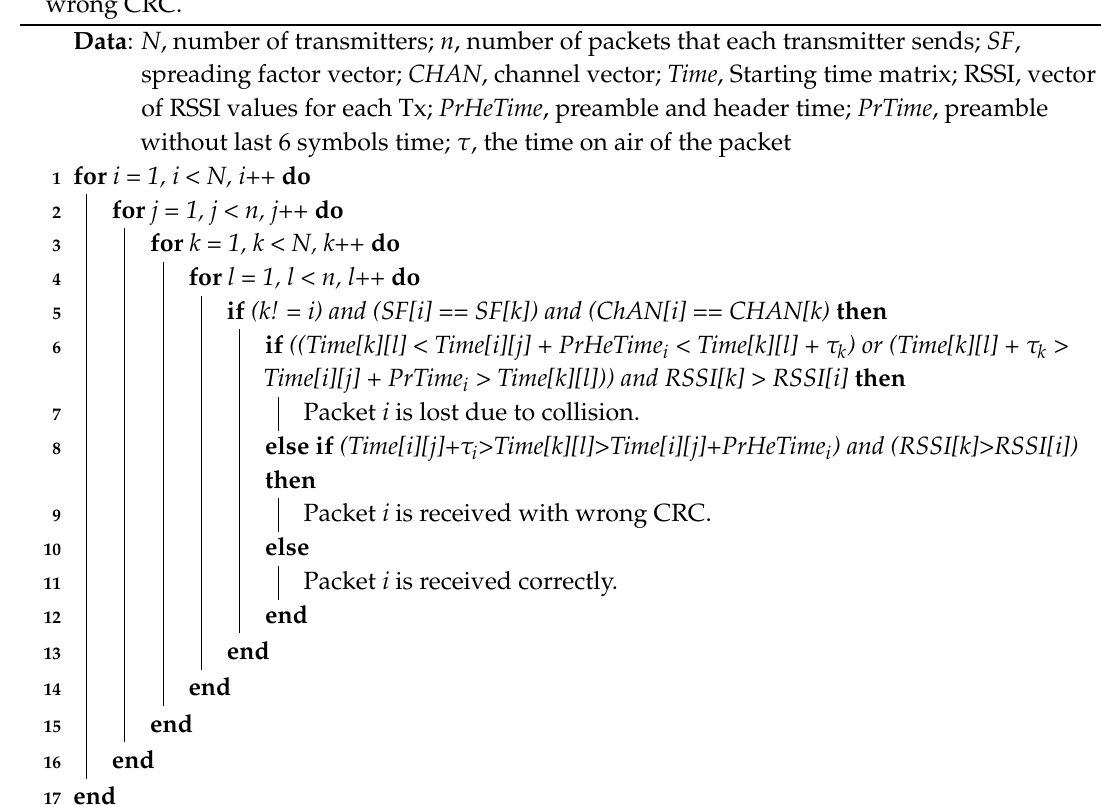
Algorithm 1: Algorithm to determine the packet collisions and packets received with the wrong